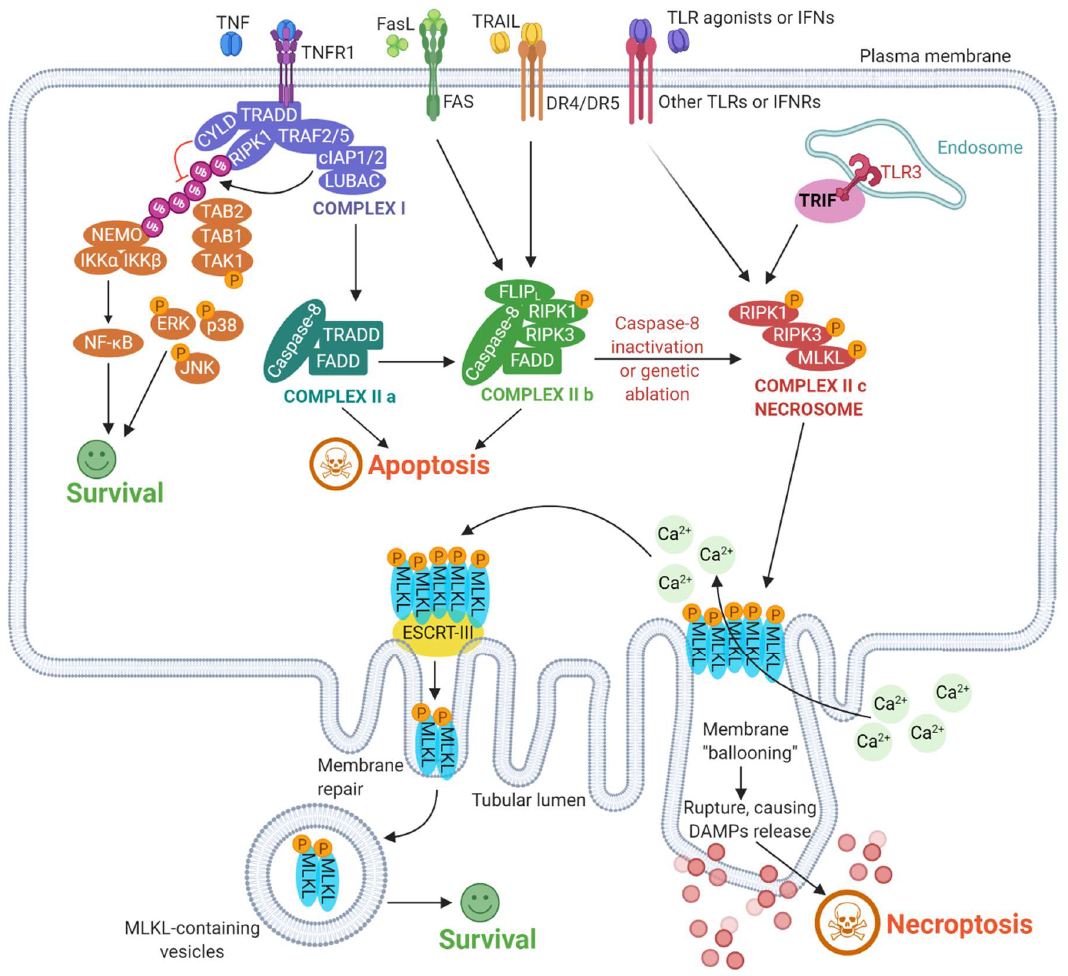
Figure2. Schematicoverviewofthemechanismsandcellfatedecisions’crosstalkunderlyingnecroptosis induction. See the text for further details on the pathway. Calcium (Ca 2 + ), cellular inhibitor of apoptosis protein 1 / 2 (cIAP1 / 2), cylindromatosis (CYLD), death receptor (DR), damage-associated molecular patterns (DAMPs), extracellular signal-regulated kinases (ERK), endosomal sorting complexes required for transport III (ESCRT-III), fas associated via death domain (FADD), FAS ligand (FASL), FLICE-like inhibitory protein (FLIPL), interferon receptor (IFNR), I κ B kinase α / β (IKK α / β ), c-Jun N-terminal kinase (JNK), linear ubiquitin chain assembly complex (LUBAC), mixed lineage kinase domain like pseudokinase (MLKL), NF- κ B essential modulator (NEMO), nuclear factor kappa-light-chain-enhancer of activated B-cells (NF- κ B), receptor-interacting serine / threonine-protein kinase 1 / 3 (RIPK1 / 3), TAK-1 binding protein 1 / 2 (TAB1 / 2), transforming growth factor- β -activated kinase 1 / 2 (TAK), t-cell receptor (TCR), toll-like receptor (TLR), tumor necrosis factor (TNF), tumor necrosis factor receptor 1 (TNFR1), TNF receptor type1-associated death domain (TRADD), TNF receptor associated factor 2 / 5 (TRAF2 / 5), TNF-related apoptosis-inducing ligand (TRAIL), toll / il-1 receptor domain-containing adaptor inducing interferon- β (TRIF), ubiquitinated